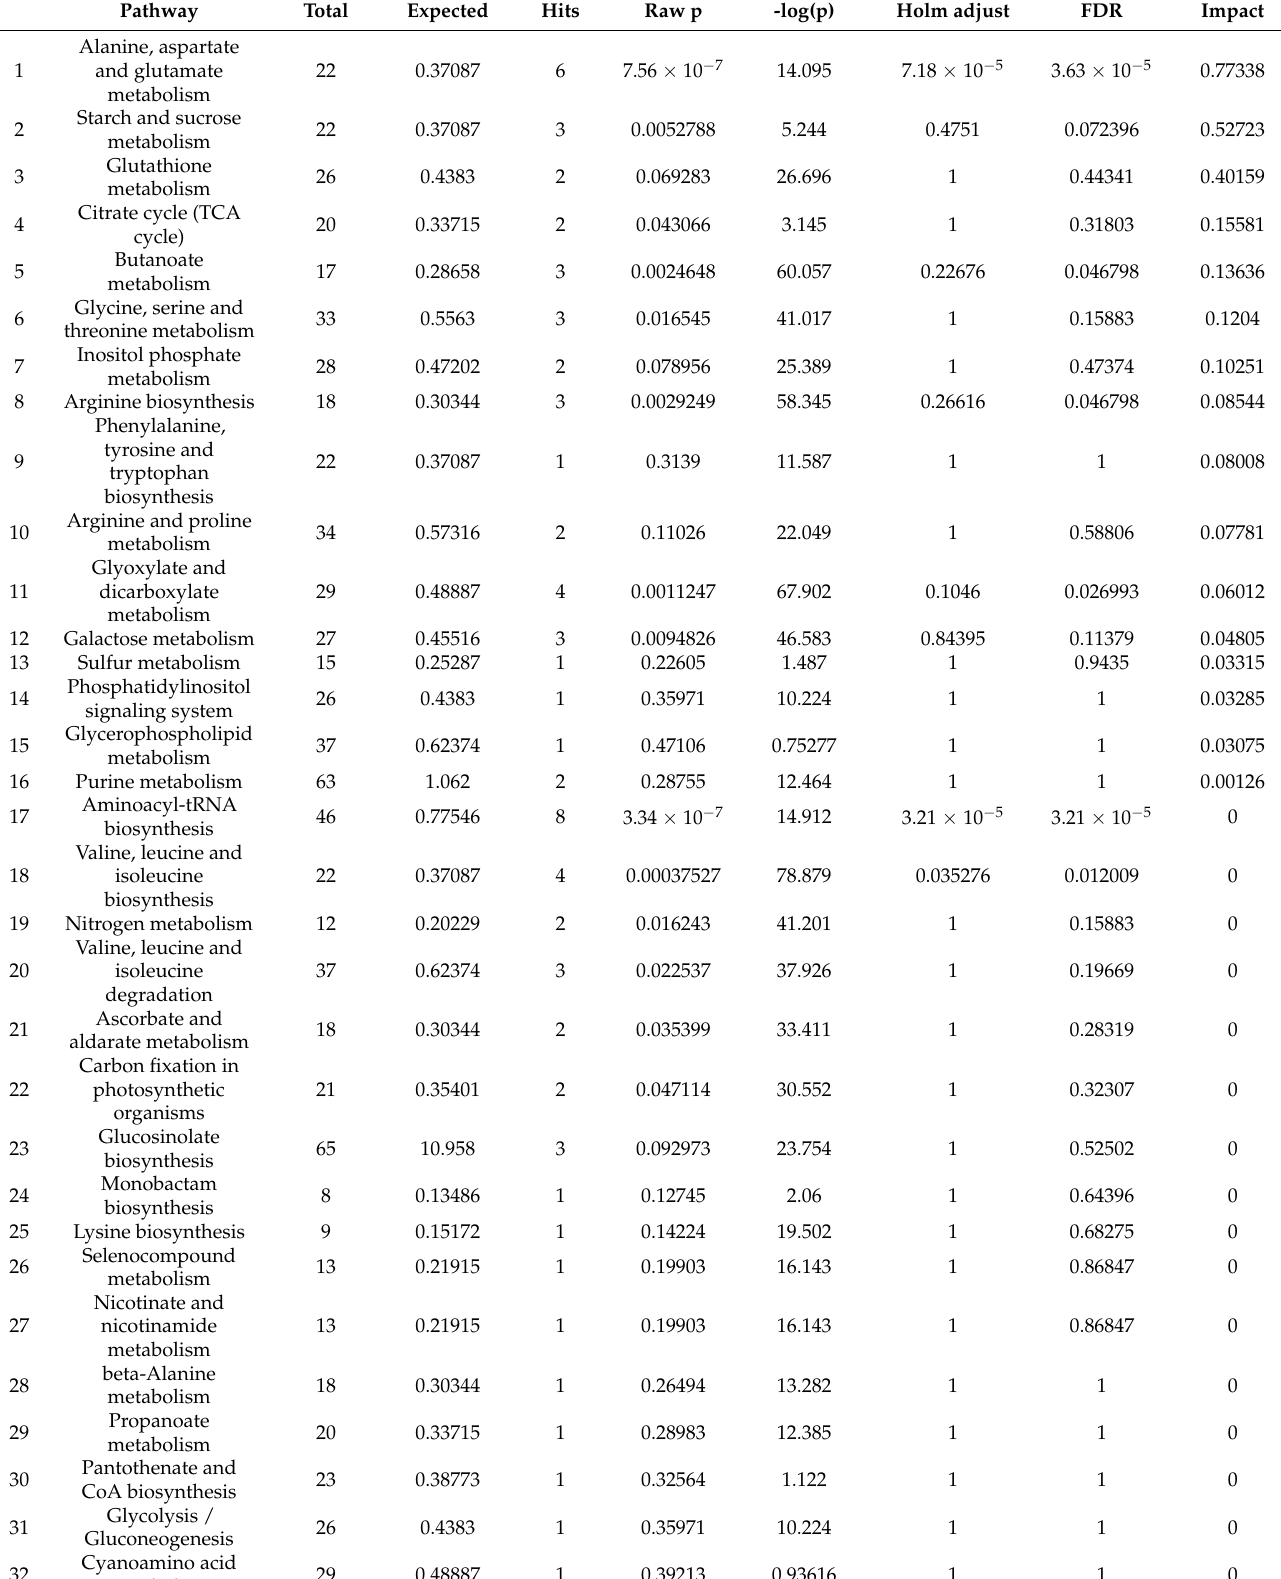
Table 6. Result from pathway analysis order by impact factor